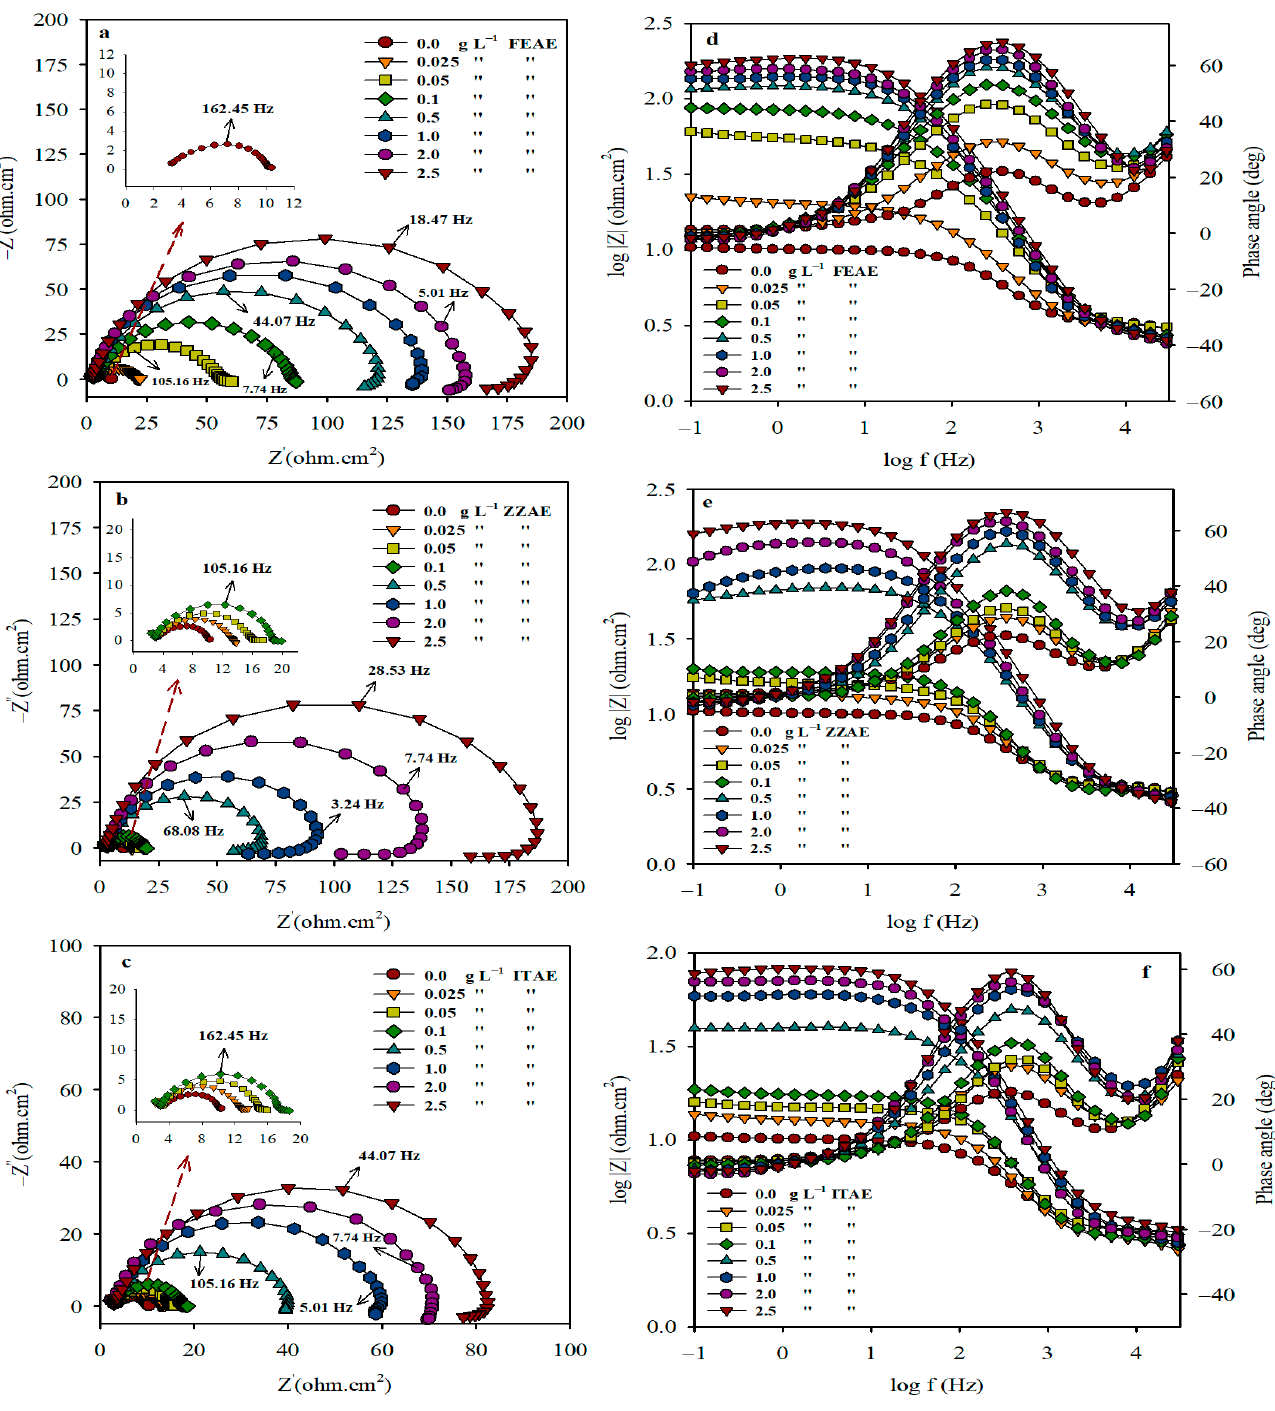
Figure 1. Nyquist ( a – c ), Bode impedance modulus and phase angle plots ( d – f ) for mild steel corrosion in 2 M H 3 PO 4 with and without different concentrations of the studied plant extracts at 30 °C. Figure 1d–f depicts the Bode impedance moduli of log(f)–log(Z) obtained for MS with and without various concentrations of the inhibitors. The Bode moduli show linearity at intermediate frequencies, which is more noticeable in the presence of the inhibitors, show- ing higher slopes than the free solution [46]. The linearity increases with the inhibitor con- centration, indicating a higher protection ability at higher inhibitor concentrations. The increase in the absolute impedance at low frequencies further proves that increasing the